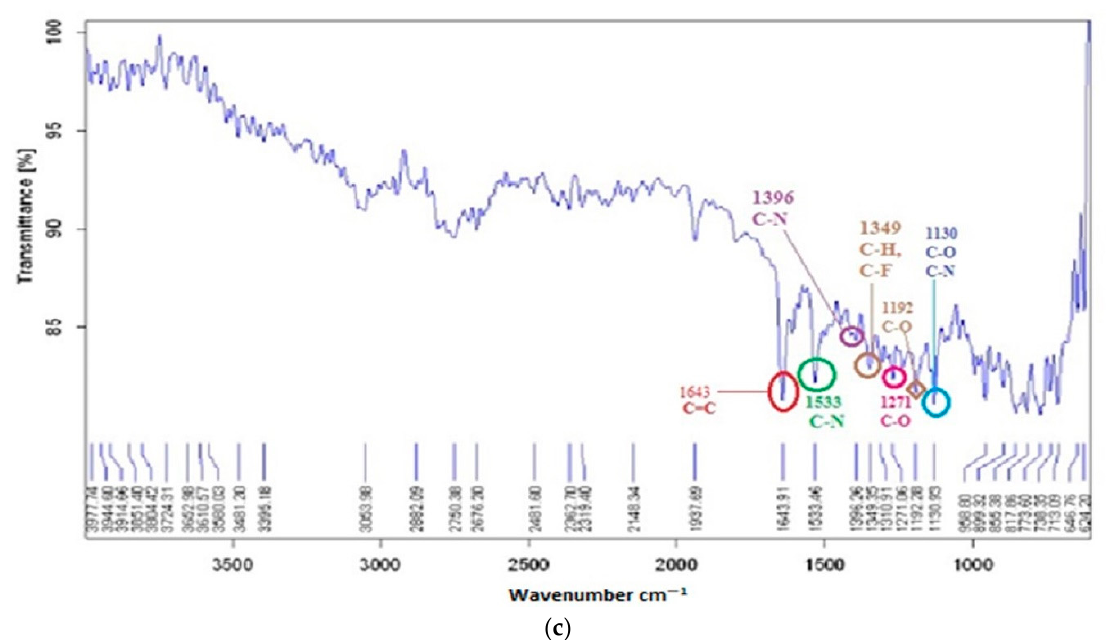
( c ) Figure 1. FTIR spectra for ( a ) physical mixture, ( b ) NP formulation and ( c ) drug (RIS).